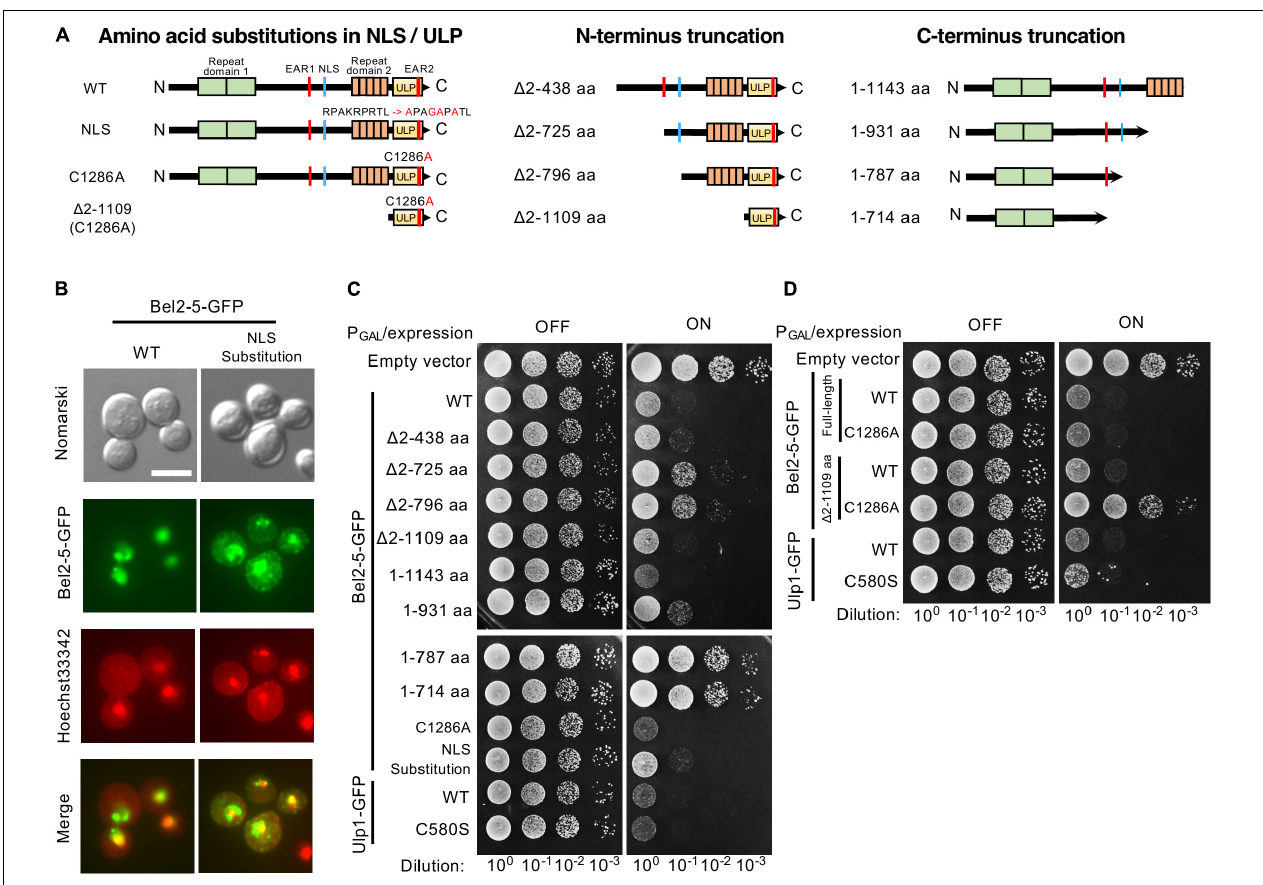
FIGURE 3 | Expression of Bel2-5 and its derivatives in yeast cells. (A) Schematic representation of Bel2-5 and its derivatives used for heterologous expression in yeast cells. Amino acid substitutions in the nuclear localization signal (NLS) and catalytic core of the ubiquitin-like protease (ULP) domain of Bel2-5. The Bel2-5 N- or C-terminal truncated constructs. (B) Subcellular localization of wild-type Bel2-5 and its mutant on the predicted NLS motif in yeast cells. Bel2-5 was tagged with a GFP reporter. Yeast cells were stained with Hoechst dye solution as a counterstain for Bel2-5 localization. From top to bottom: unstained yeast cells (Nomarski), the GFP-labeled Bel2-5 effector, yeast cells stained with Hoechst 3342 dye, and combined GFP-tagged Bel2-5 and Hoechst 3342 dye staining. Scale bars: 5 µ m. (C, D) Expression of the GFP-tagged Bel2-5 effector and its derivative mutants in yeast cells. Bel2-5 expression was under the control of the inducible promoter GAL1